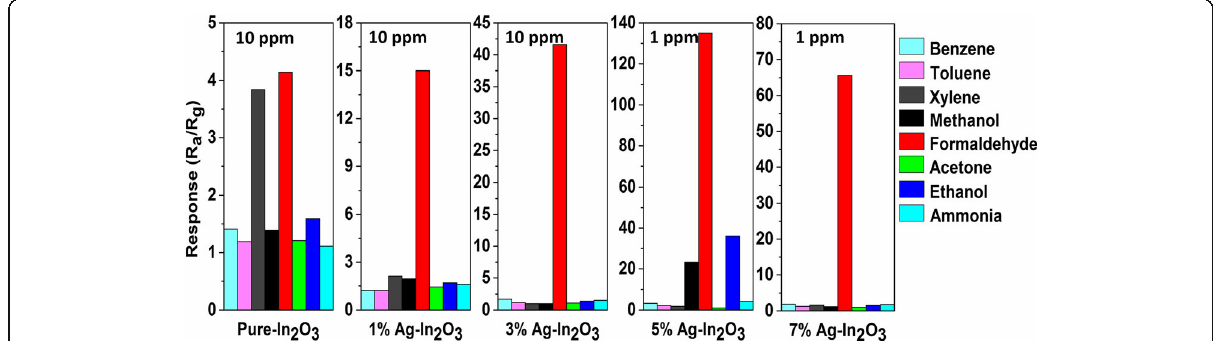
Fig. 8 The gas response of pure In 2 O 3 , 1%Ag-In 2 O 3 , and 3%Ag-In 2 O 3 (benzene, toluene, xylene, methane, formaldehyde, acetone, ethanol, and ammonia) with a concentration of 10 ppm at 30 °C, 5%Ag-In 2 O 3 and 7%Ag-In 2 O 3 toward this gases with a concentration of 1 ppm at 30